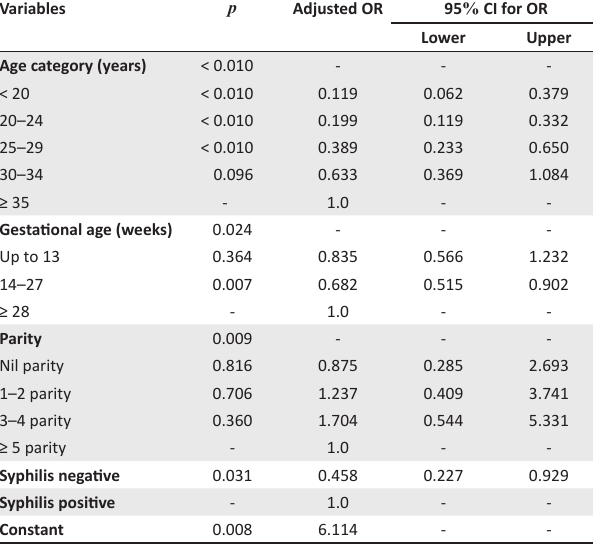
TABLE 5 : Logistic regression output for syphilis at booking visit. Variable p OR